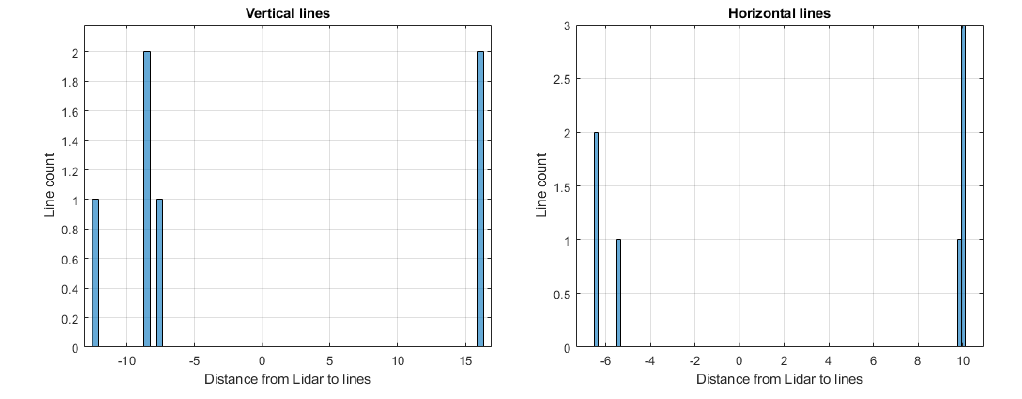
Figure 11. Histogram of HT